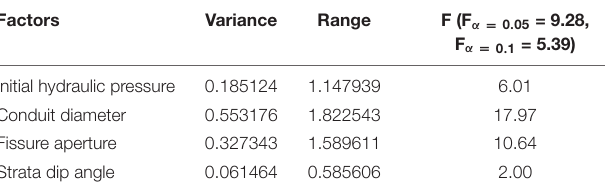
TABLE 4 | Statistical analysis the simulation experiment results.